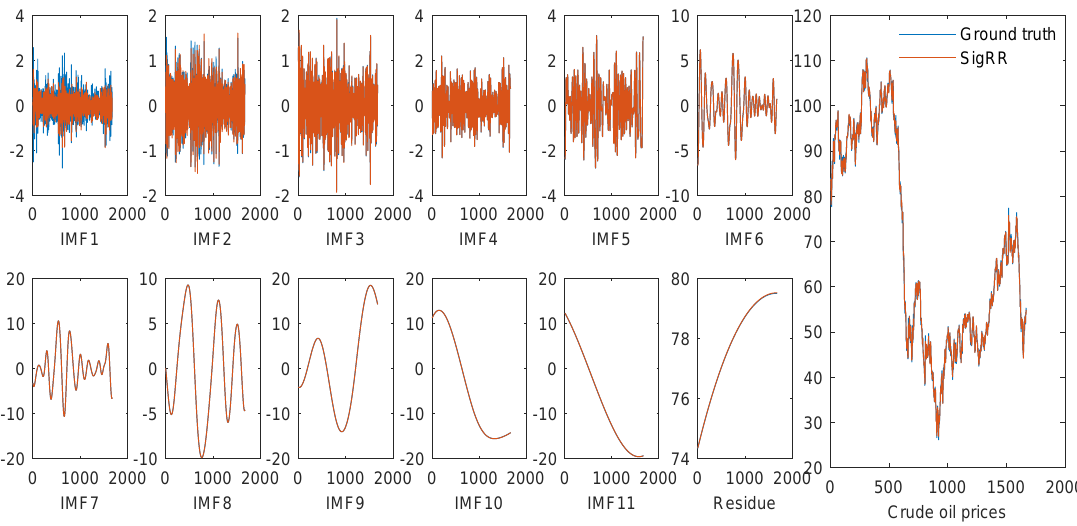
Figure 7. The individual and final forecasting results by